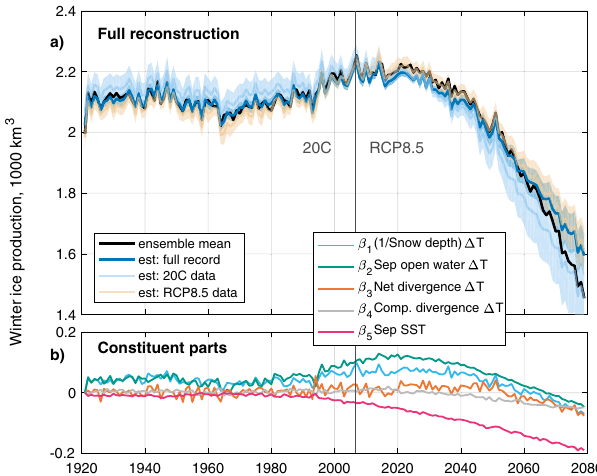
Fig. 7 | Application of linear model to forced changes in ice production. a Ensemble-mean winter sea ice production in CESM-LE (black line), and recon- struction of ensemble mean using regressions trained on internal variability over the 20C run (light blue line), RCP8.5 run (light orange line) and full 1920 – 2080 timeseries (heavy blue line). Uncertainty windows derived from 40 reconstruction estimates using the regression coef fi cients associated with each model run (grey dots,Fig.5):thewindowisthe1standarddeviationenvelope. b Contributiontothe reconstruction made by each component of the linear model, when trained upon internal variability from the full timeseries, plotted relative to the fi rst winter (1920/1921).